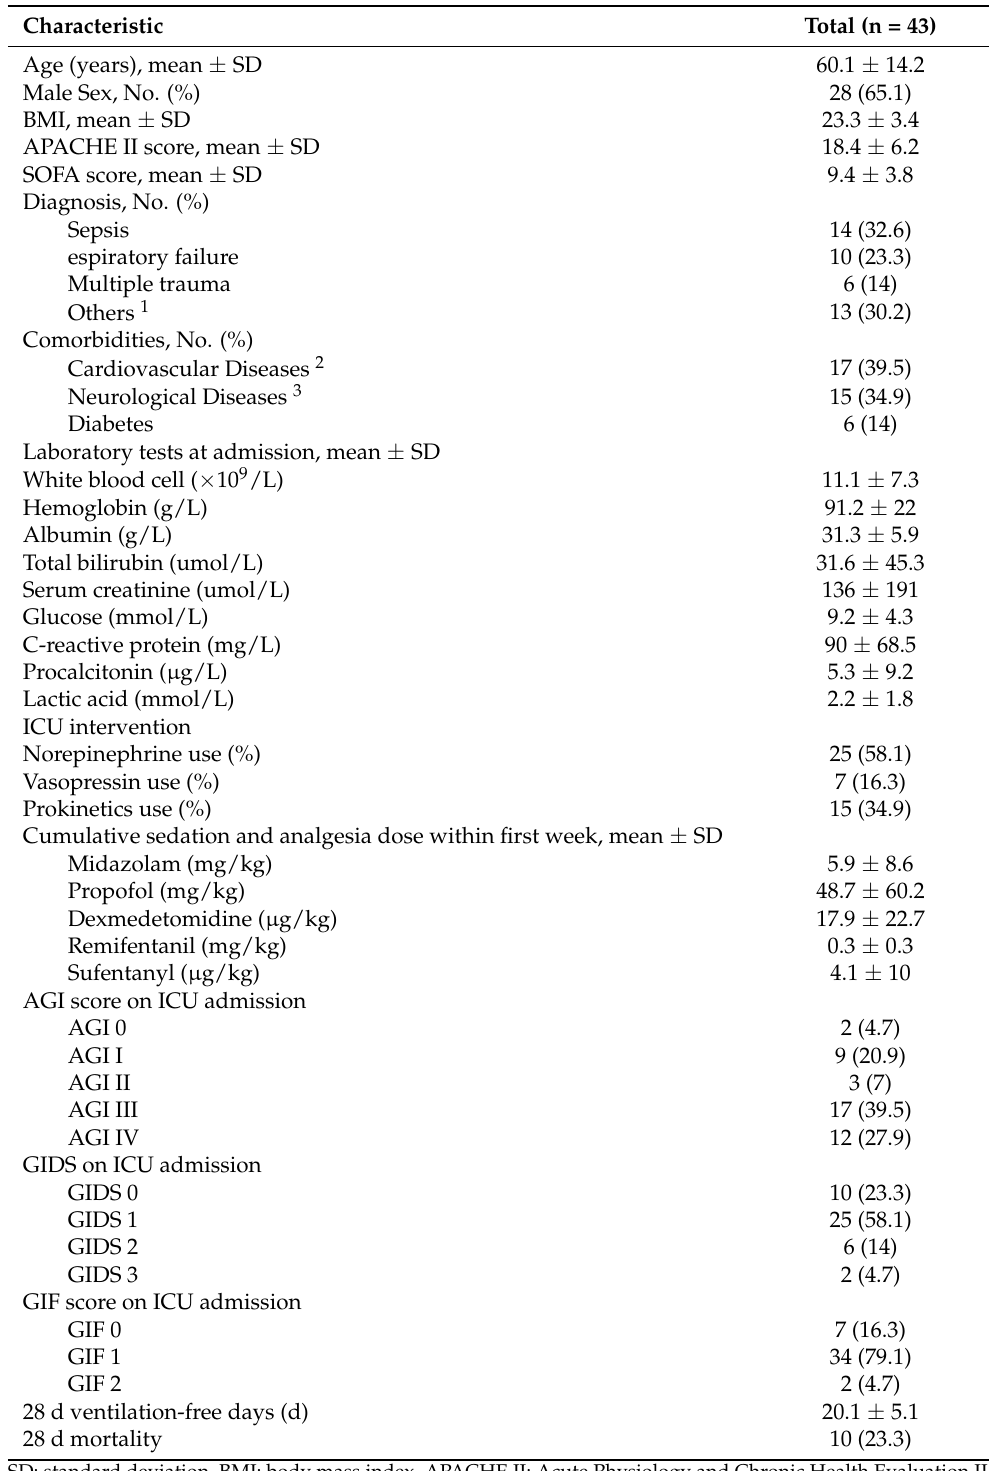
Table 1. The basic information and characterization of enrollment